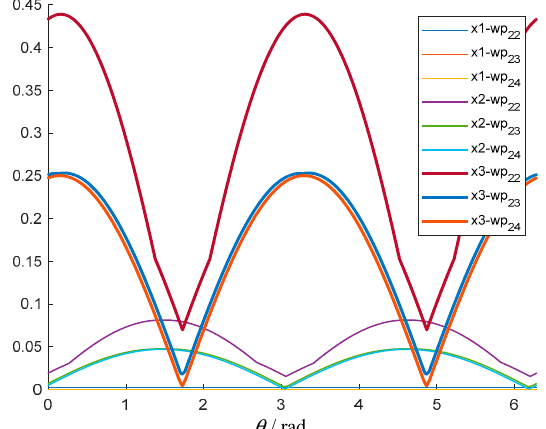
Figure 12. Maximal absolute values of wavelet packets ( wp 2,2 ( t ) , wp 2,3 ( t ) , wp 2,4 ( t ) ) of the three simulated signals with different initial phases.